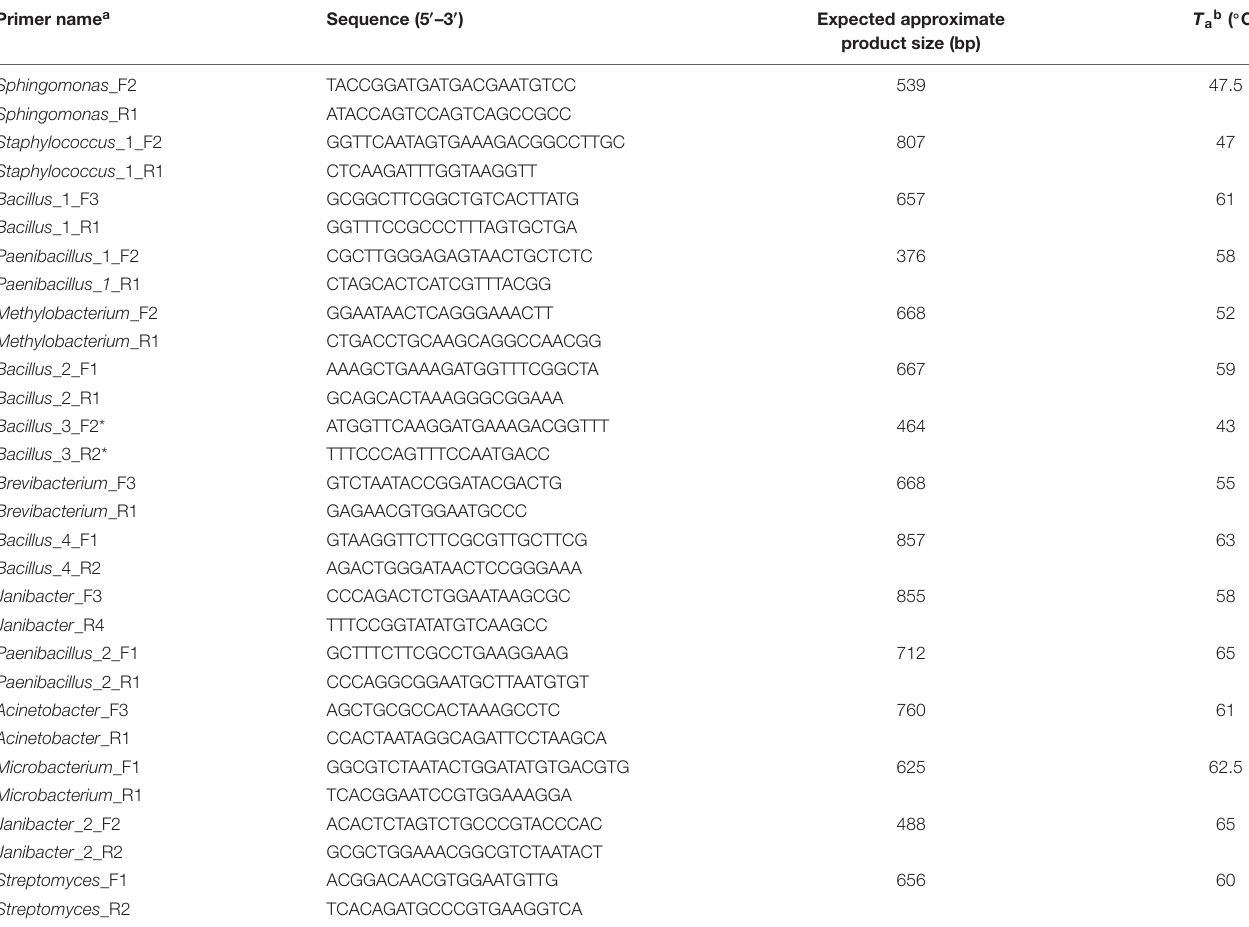
TABLE 3 | Selected primers for the specific PCR amplification of bacterial 16S rDNA genes of different taxonomic groups. Primer name